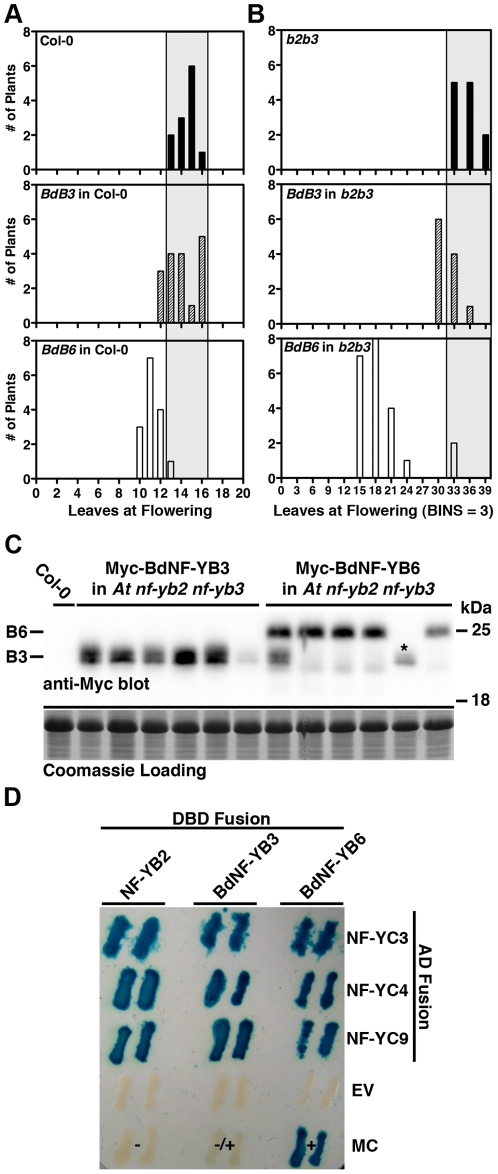
As predicted by orthology, BdNF-YB6, but not BdNF-YB3, can rescue a late flowering Arabidopsis mutant.
A) Overexpression of BdNF-YB6 drives early flowering in Col-0. Bars represent numbers of individual T1 plants flowering at a specific leaf number. The label in the upper left corner of each panel lists the genotype and transgene (where applicable). BdB3 and BdB6 are abbreviations for 35S∶BdNF-YB3 and 35S∶BdNF-YB6, respectively. The gray bar extending from the top panel through the lower panels shows the normal range of Col-0 flowering times. Means (±SD) were 14.5 (0.90), 14.1 (1.52), and 11.2 (1.95) for Col-0, 35S∶BdNF-YB3 and 35S∶BdNF-YB6, respectively. A non-parametric Kruskal-Wallis test (InStat 3.0, GraphPad Software) was highly significant at p<0.0001. Dunn's multiple comparison procedure (MCP) was highly significant (p<0.001) for 35S∶BdNF-YB6 compared to Col-0. B) Overexpression of BdNF-YB6 in the Arabidopsis nf-yb2 nf-yb3 mutant rescues late flowering. Means were 35.2 (1.95), 31.5 (2.02), and 19.2 (4.97) for nf-yb2 nf-yb3, 35S∶BdNF-YB3, and 35S∶BdNF-YB6, respectively. Kruskal-Wallis, p<0.0001; Dunn's MCP, p<0.001 for the 35S∶BdNF-YB6 comparison to nf-yb2 nf-yb3, but not different for the 35S∶BdNF-YB3 comparison to nf-yb2 nf-yb3 or the 35S∶BdNF-YB6 comparison to Col-0. C) Protein blotting of independent transgenic lines (six for each transgene type) demonstrated that both BdNF-YB3 and BdNF-YB6 accumulate in the nf-yb2 nf-yb3 background. Asterisk for BdNF-YB6 lane represents a known non-rescuing line. Coomassie staining of the transferred gel shows equal loading and equal transfer was confirmed by Ponceau red staining (not shown). D) Yeast two-hybrid assays demonstrate that both BdNF-YB3 and BdNF-YB6 can physically interact with Arabidopsis NF-YC3, 4, and 9. DBD, DNA-binding domain; AD, activation domain. EV - empty vector; MC - manufacturer's (Invitrogen) controls (+ strong interactor, +/− weak interactor, - non-interactor).